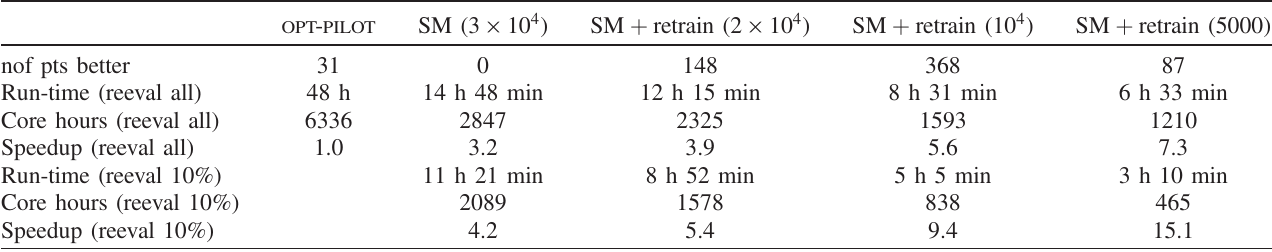
TABLE V. Solution quality and run-time for different optimization methods. “ SM ” is an abbreviation for “ surrogate model. ” OPT - PILOT denotes the massively parallel MOGA implementation combined with TRACY , in particular the optimization from Sec. III C. “ SM ( 3 × 10 4 ) ” and “ SM þ retrain ( 2 × 10 4 ) ” refer to the approaches described in Secs. VA and V B, respectively. “ SM þ retrain ( 10 4 ) ” and “ SM þ retrain (5000) ” are described in Sec. V C for N ¼ 5000 and N ¼ 2500 , respectively. The number in the parentheses is the combined size of the used samples. “ SM þ retrain ( 2 × 10 4 ) ” therefore corresponds to N ¼ 10 4 . “ nof pts better ” refers to the number of design points in the last generation that satisfy the constraints in Eq. (28) and have all objectives better than the manually obtained solution. To determine the quality of a generation, “ nof pts better ” should be used together with the information in Table VI. For example, “ nof pts better ” is higher for N ¼ 5000 than for N ¼ 10 4 , but better individual values for F 1 and F 2 are achieved when N ¼ 10 4 (see Table VI, point-4 and point-5 ). The quality of both approaches is comparable to the quality of the approach from Sec. III C, denoted OPT - PILOT . “ reeval all ” refers to the case where all 10 4 individuals in the last generation are reevaluated using 4 TRACY , which accounts for around 3 h 50 min of the total run-time. “ reeval 10% ” refers to the case where only 1000 of the 10 individuals in the last generation are reevaluated. The speedup is computed with respect to the OPT - PILOT approach in the first column. OPT - PILOT